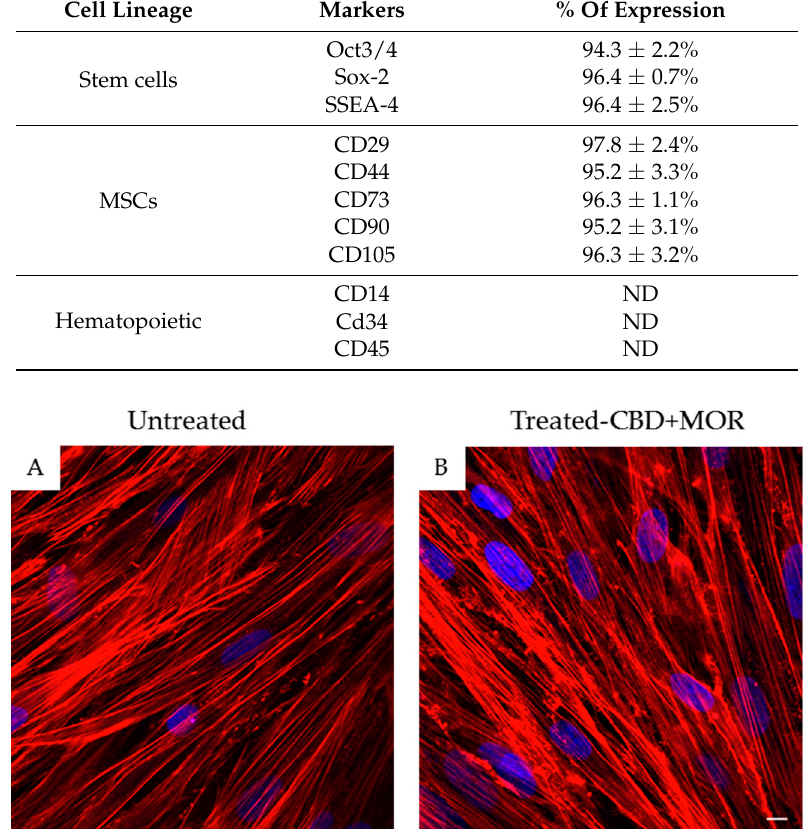
Figure 1. Morphology of hPDLSCs. ( A ) Confocal laser scanning observations of untreated hPDLSCs. ( B ) Confocal laser scanning observations of hPDLSCs treated with the mixture CBD+MOR. Red fluorescence: F-actin; blue fluorescence: nuclei. Scale bar: 5 µm.